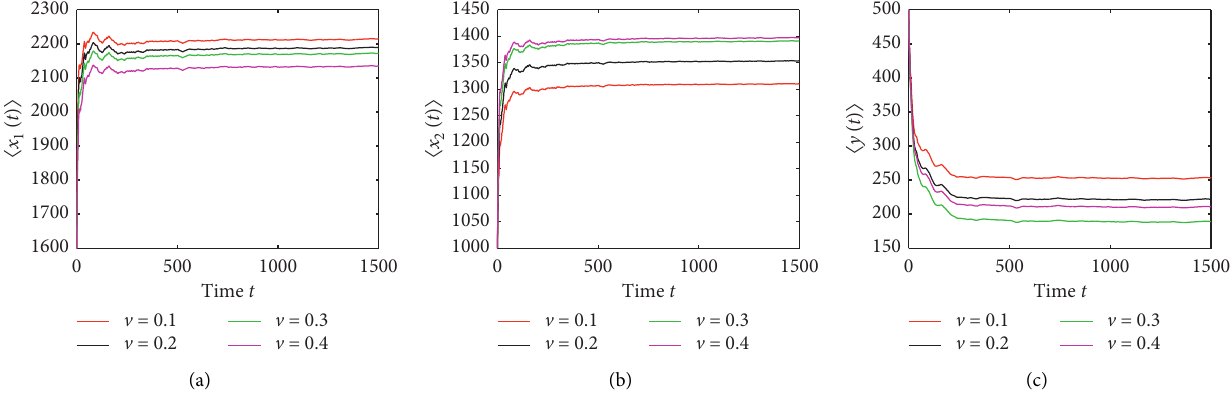
( t )〉 , (b) prey 〈 x ( t )〉 , and (c) predator 1 2